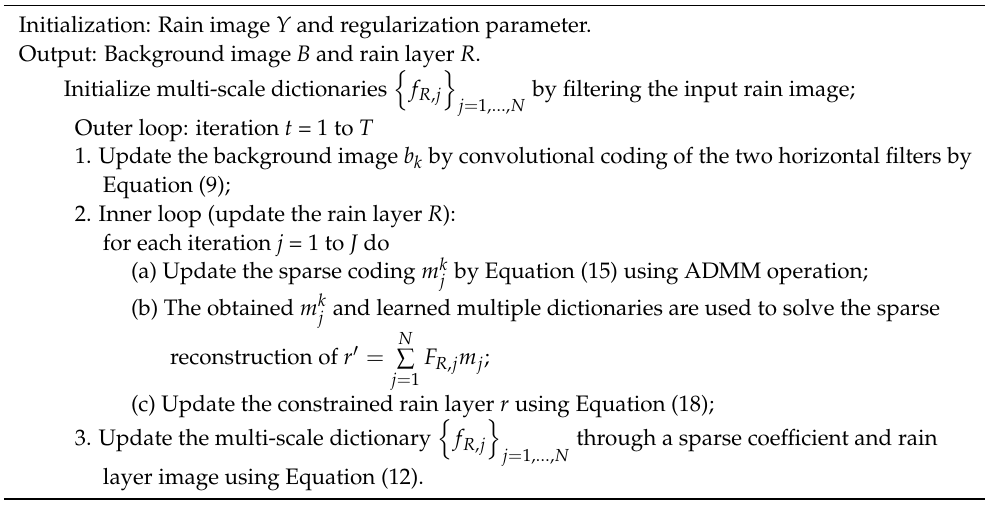
Algorithm 1 Pseudocode of Single Image Rain Removal Based on Multi-scale Dictionary